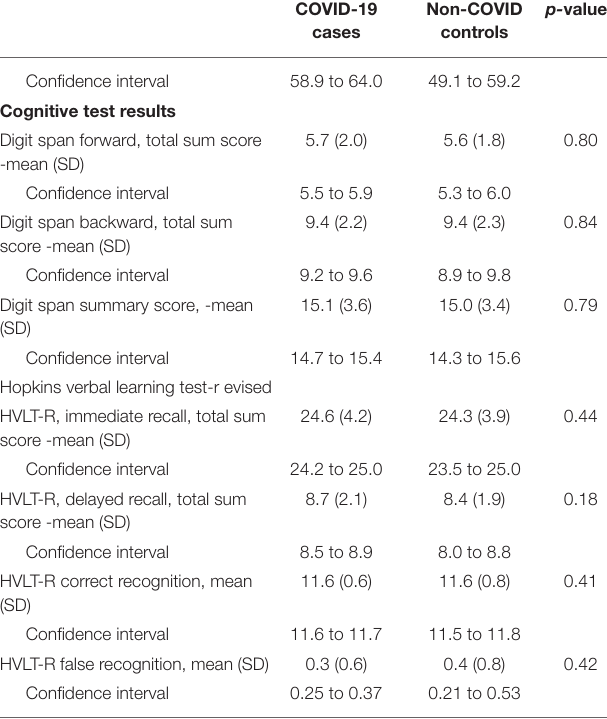
TABLE 2 | Symptoms, clinical and laboratory findings, and cognitive test results among COVID-19 cases and non-COVID controls.